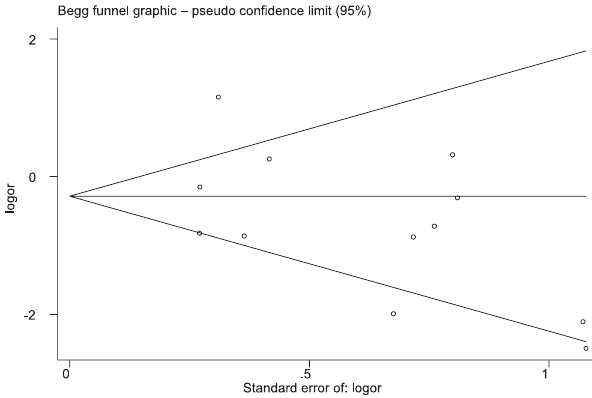
Figure 3 - Funnel plot for clinical trials comparing chemonucleolysis vs. surgery (negative log OR favors